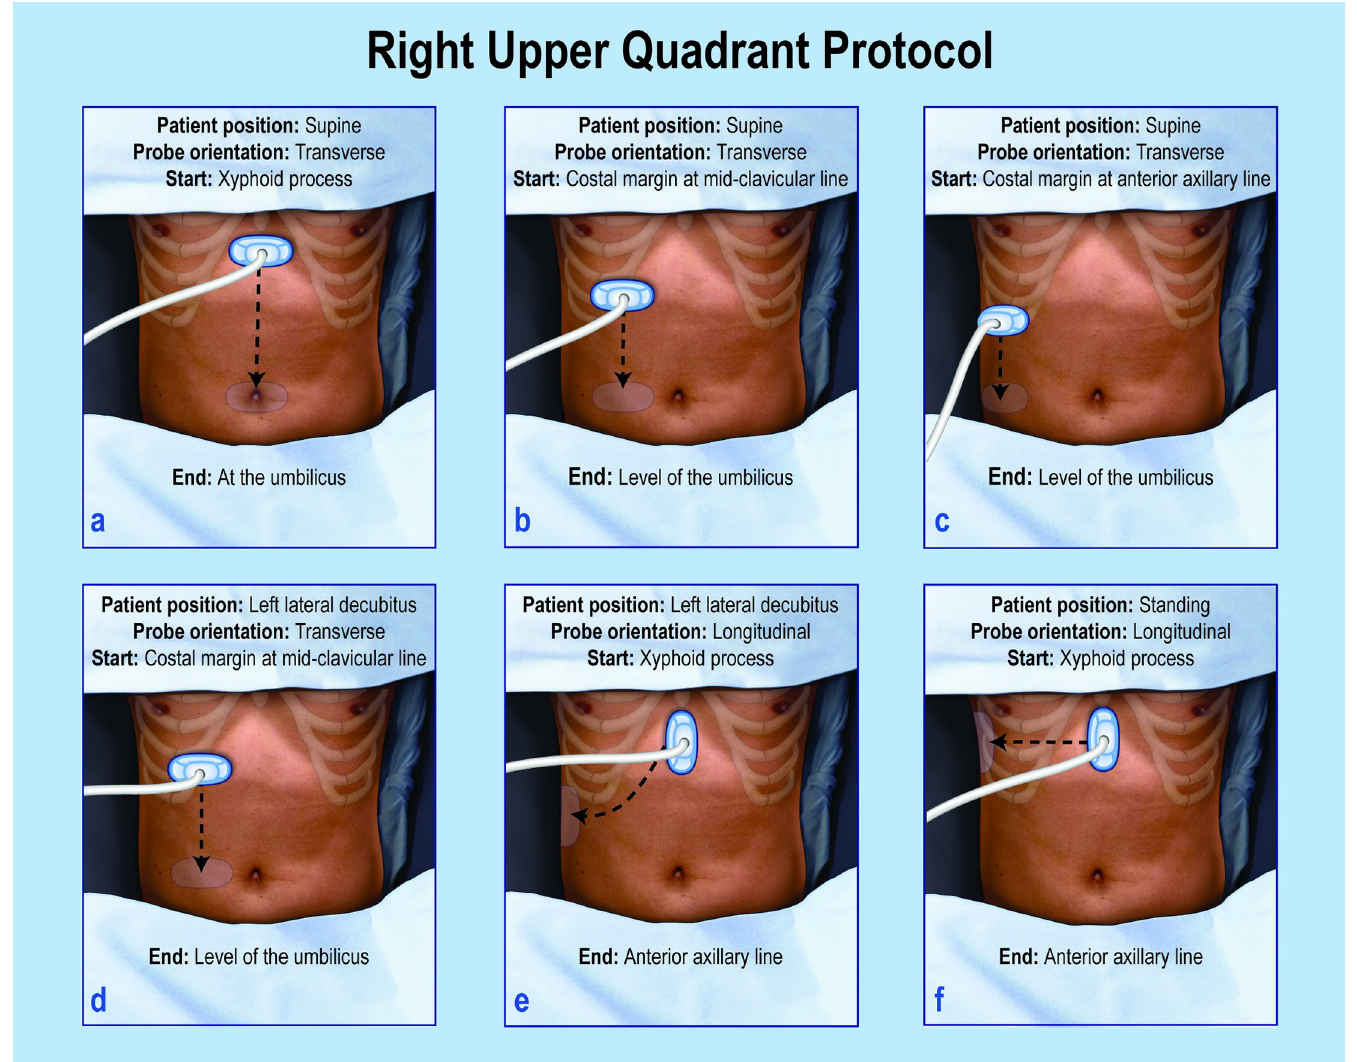
Fig 2. Overview of the RUQ protocol. The RUQ protocol involves 6 sweeps each beginning and ending with an arc of the probe that has not been illustrated for simplicity. An arc consists of a fan-like motion of the probe (shown in S1 File). The arcing of the probe allows maximal visualization. Steps a-c involve transverse sweeps of the probe in the supine position. Steps d and e are conducted in the left lateral decubitus position. Step f is performed in the standing position. The patient takes a deep breath during each step.